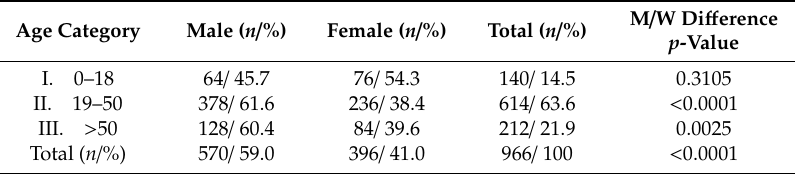
Table 1. Age and gender characteristics of the patient group.